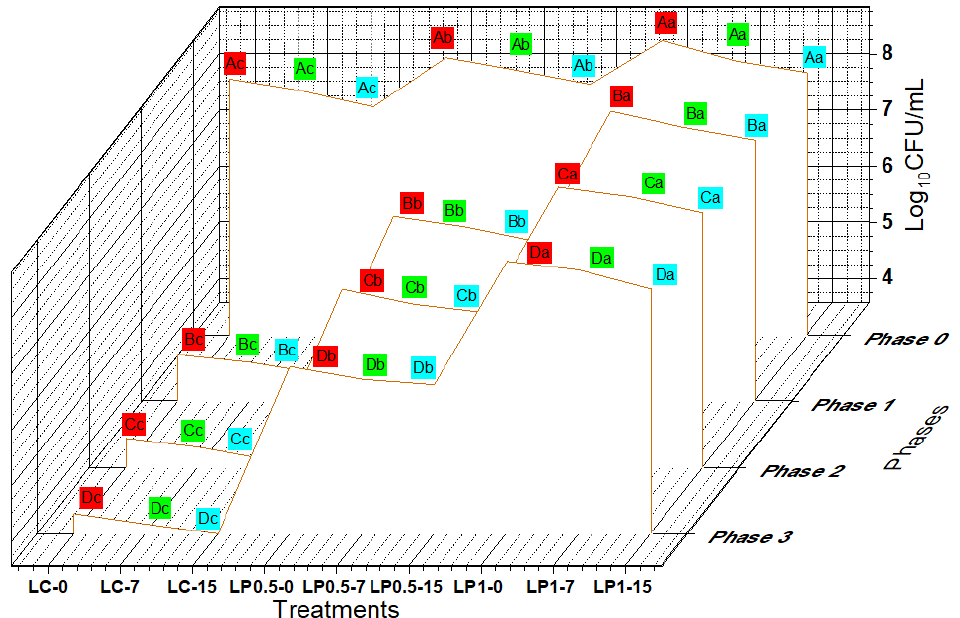
Figure 4. Survival of EcN (viable count; log 10 cfu/mL) in probiotic labneh during cold storage before (phase 0) and during exposure to in vitro simulated gastric conditions (phase 1), and enteric conditions (phase 2, pH 4.3–5.2) and simulated enteric conditions (phase 3, pH 7.0–7.3). LC-0 (Labneh without PFPP at day 0), LC-7 (Labneh without PFPP after 7 days of storage), LC-15 (Labneh without PFPP after 15 days of storage), LP 0.5-0 (Labneh with 0.5% of PFPP at day 0), LP 0.5-7 (Labneh with 0.5% of PFPP peel after 7 days of storage), LP 0.5-15 (Labneh with 0.5% of PFPP after 15 days of storage), LP 1-0 (Labneh with 1% of PFPP at day 0), and LP 1-7 and LP 1-15 (Labneh with 1% of PFPP after 7 and 15 days of storage, respectively). Different lowercase superscripts indicate significant ( p < 0.05) differences between the values for various concentrations of PFPP incorporation. Different uppercase superscripts indicate significant ( p < 0.05) differences between the values during passage in the simulated GI-tract